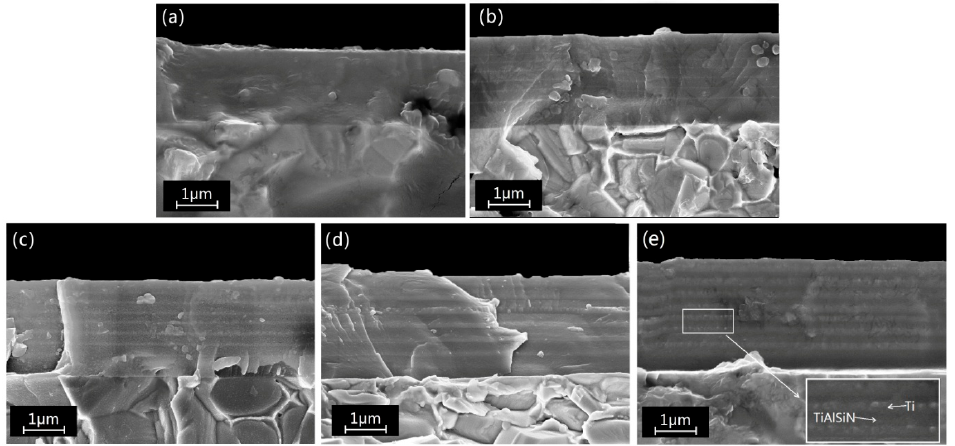
Figure 4. Cross-section of Scanning electron microscope (SEM) images of TiAlSiN/Ti coatings with di ff erent Ti thicknesses ( a ) #S1 (Ti-0 nm), ( b ) #M2 (Ti-25 nm), ( c ) #M3 (Ti-50 nm), ( d ) #M4 (Ti-100 nm), ( e ) #M5 (Ti-150 nm).